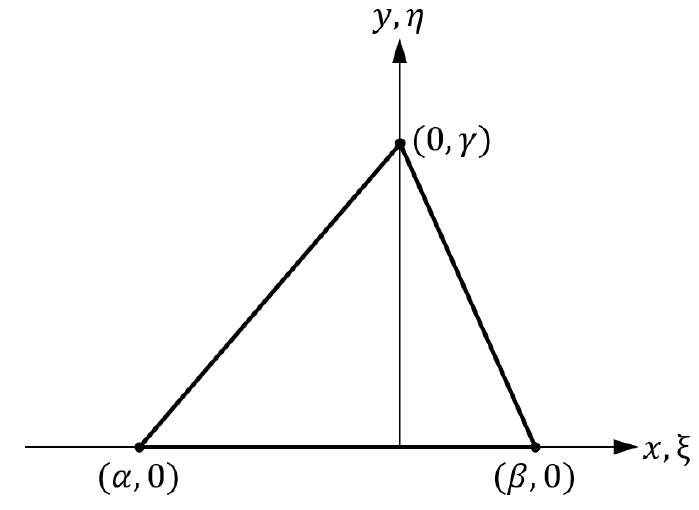
Figure 5. Local reference system for the contact